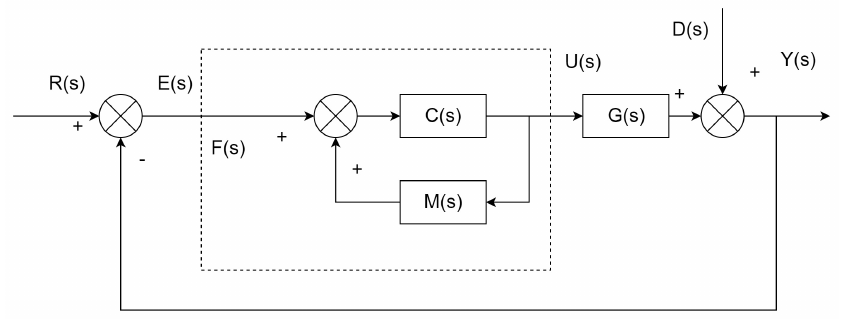
Figure 5. Description of internal model